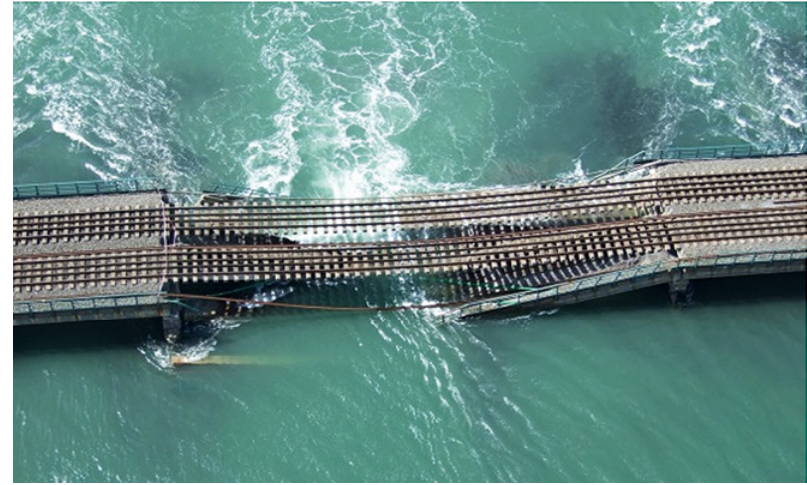
Figure 1. Malahide Bridge Collapse (21 st of August